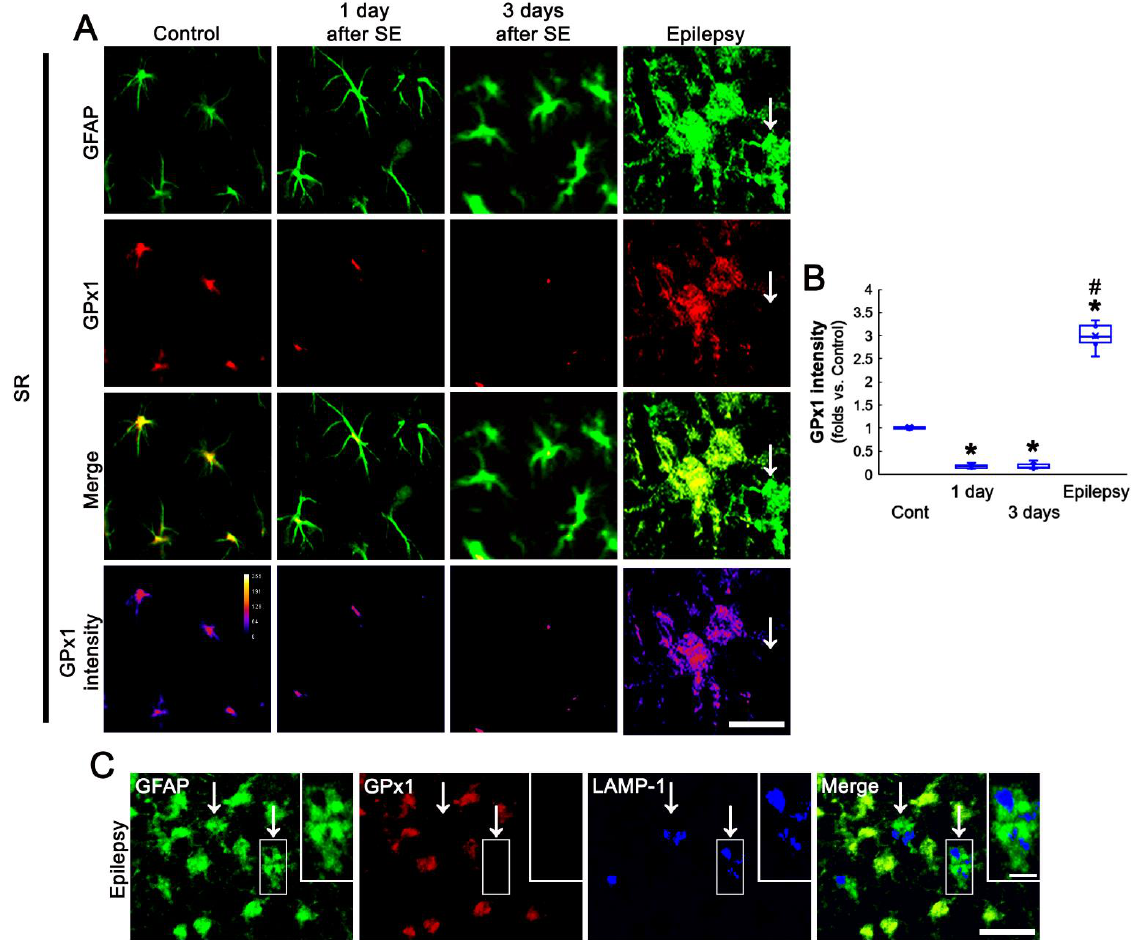
Figure 5. Astroglial GPx1 expression in the stratum radiatum (SR) of the CA1 region following SE. GPx1 expression is reduced at 1 day and 3 days after SE, but upregulated in reactive CA1 astrocytes of chronic epilepsy rats. GPx1 expression is rarely detected in clasmatodendritic CA1 astrocytes (arrows). ( A ) Representative photos of GPx1 expression and its intensity. Bar = 12.5 μm. ( B ) Quantification of GPx1 intensity in CA1 astrocytes (*, # p < 0.05 vs. control and 3 day-post SE animals, n = 7, respectively). ( C ) Representative photos of clasmatodendritic CA1 astrocytes containing lysosome-associated membrane protein 1 (LAMP1)-positive vacuoles (arrows). Insertions are high magnification of rectangles. Bar = 25 and 12.5 μm (insertion).